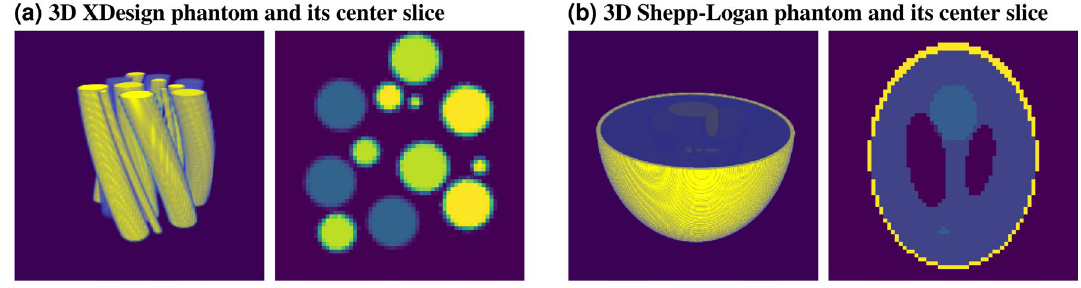
Figure 3. Simulated 3D objects 23,28 and their center